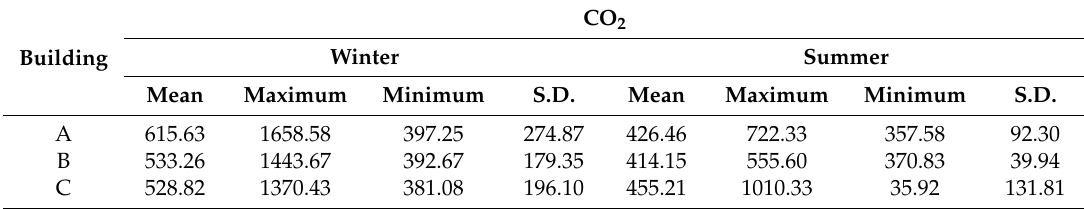
Figure 13. Variation of PMV index in Building C, during a typical day in: ( a ) winter (10 March 2016) and ( b ) summer (14 September 2016) along with the respective PPD rates.